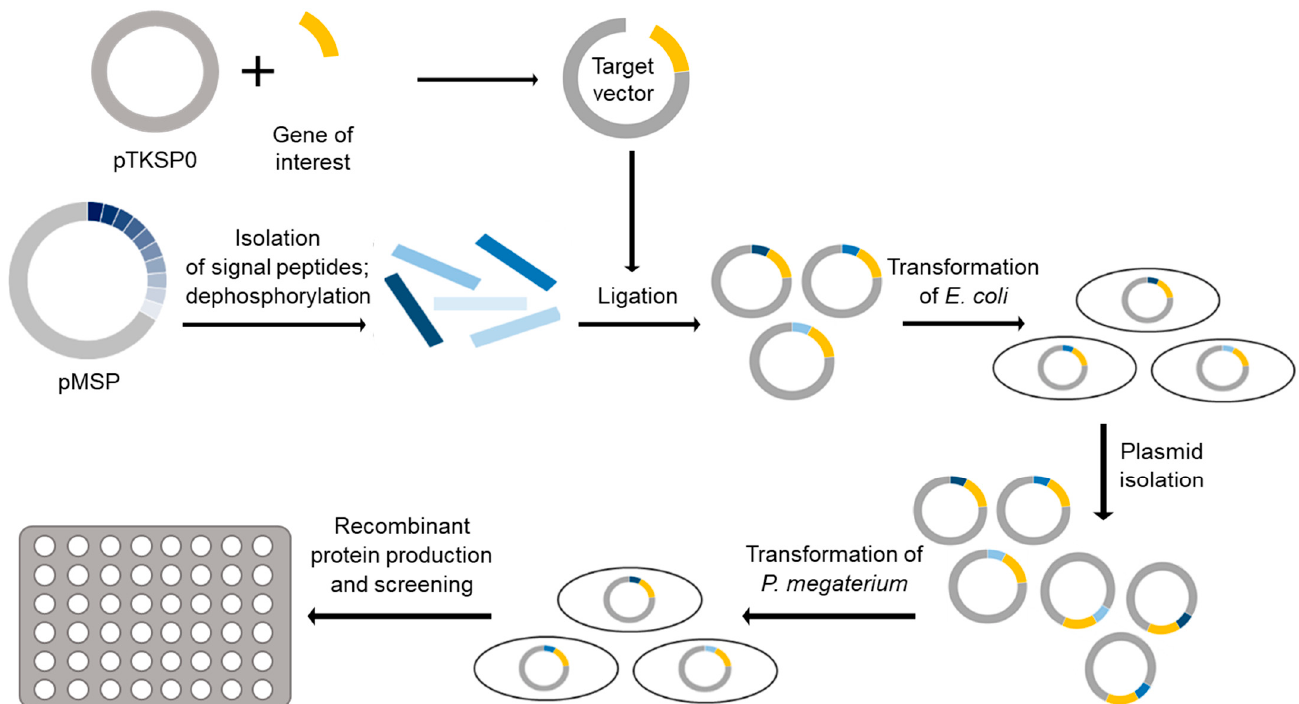
Figure 3. Illustration of cloning and screening procedure to identify efficient combinations of SP and target protein that lead to high secretion in recombinant P. megaterium . Coding sequences of SPs are shown in blue, the target gene in yellow.